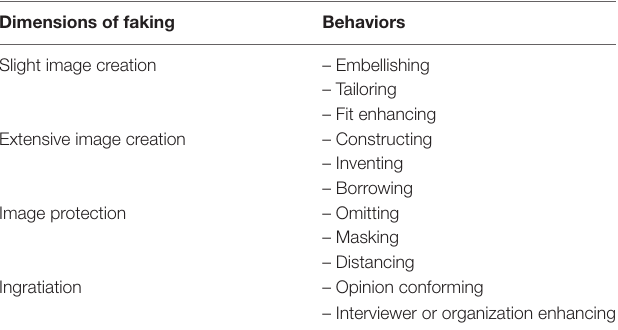
TABLE 1 | Taxonomy of Faking Behaviors (proposed by Levashina and Campion